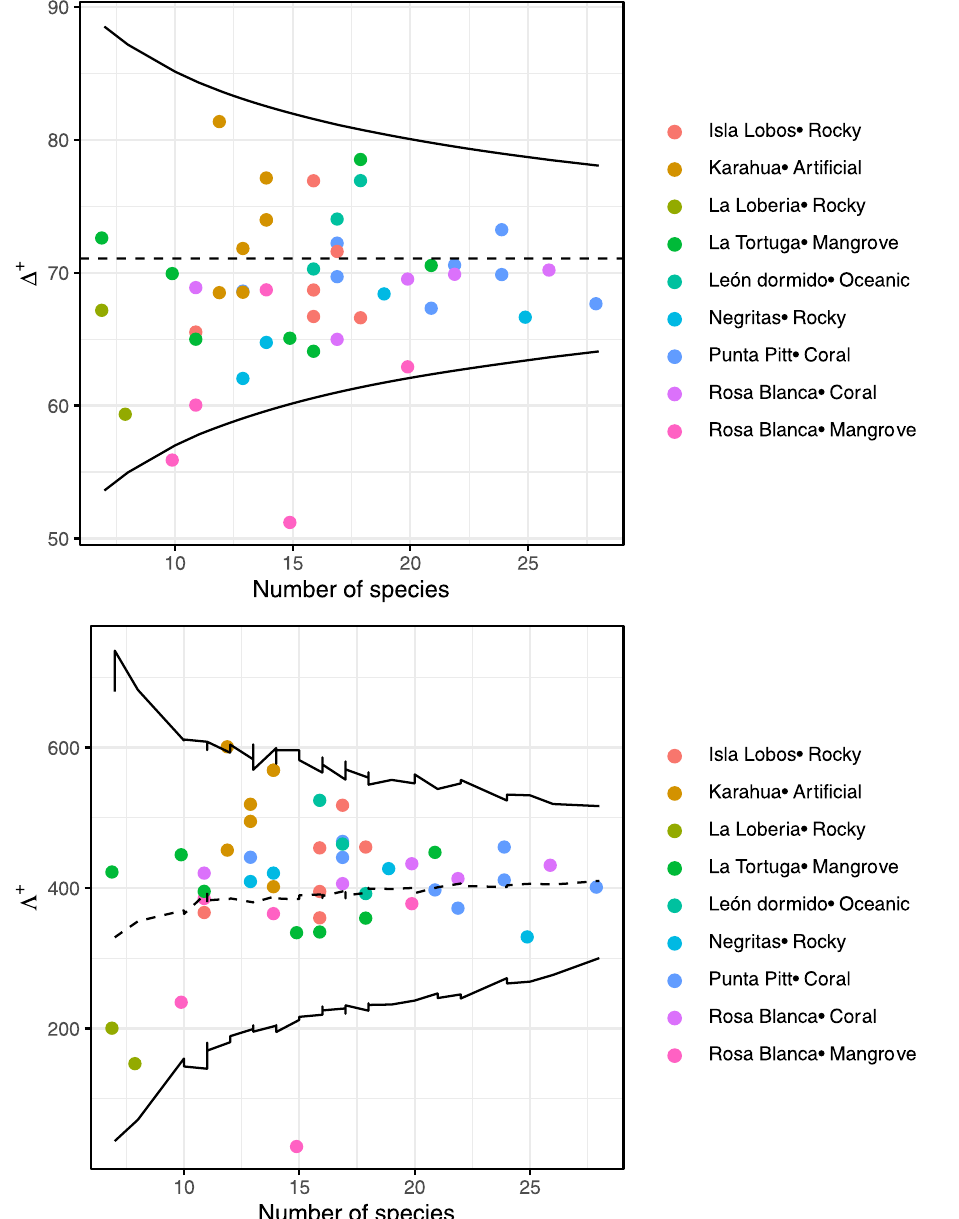
Figure 3. Funnel plot of the simulations of expected and observed average taxonomic distinctness (Δ+) and variation in taxonomic distinctness (Λ ) per site of the fish community in the southeastern Galapagos Islands. Each dot indicates each sample, and its color indicates site. The limits within thin lines indicate 95% of the simulated Δ+ and Λ+